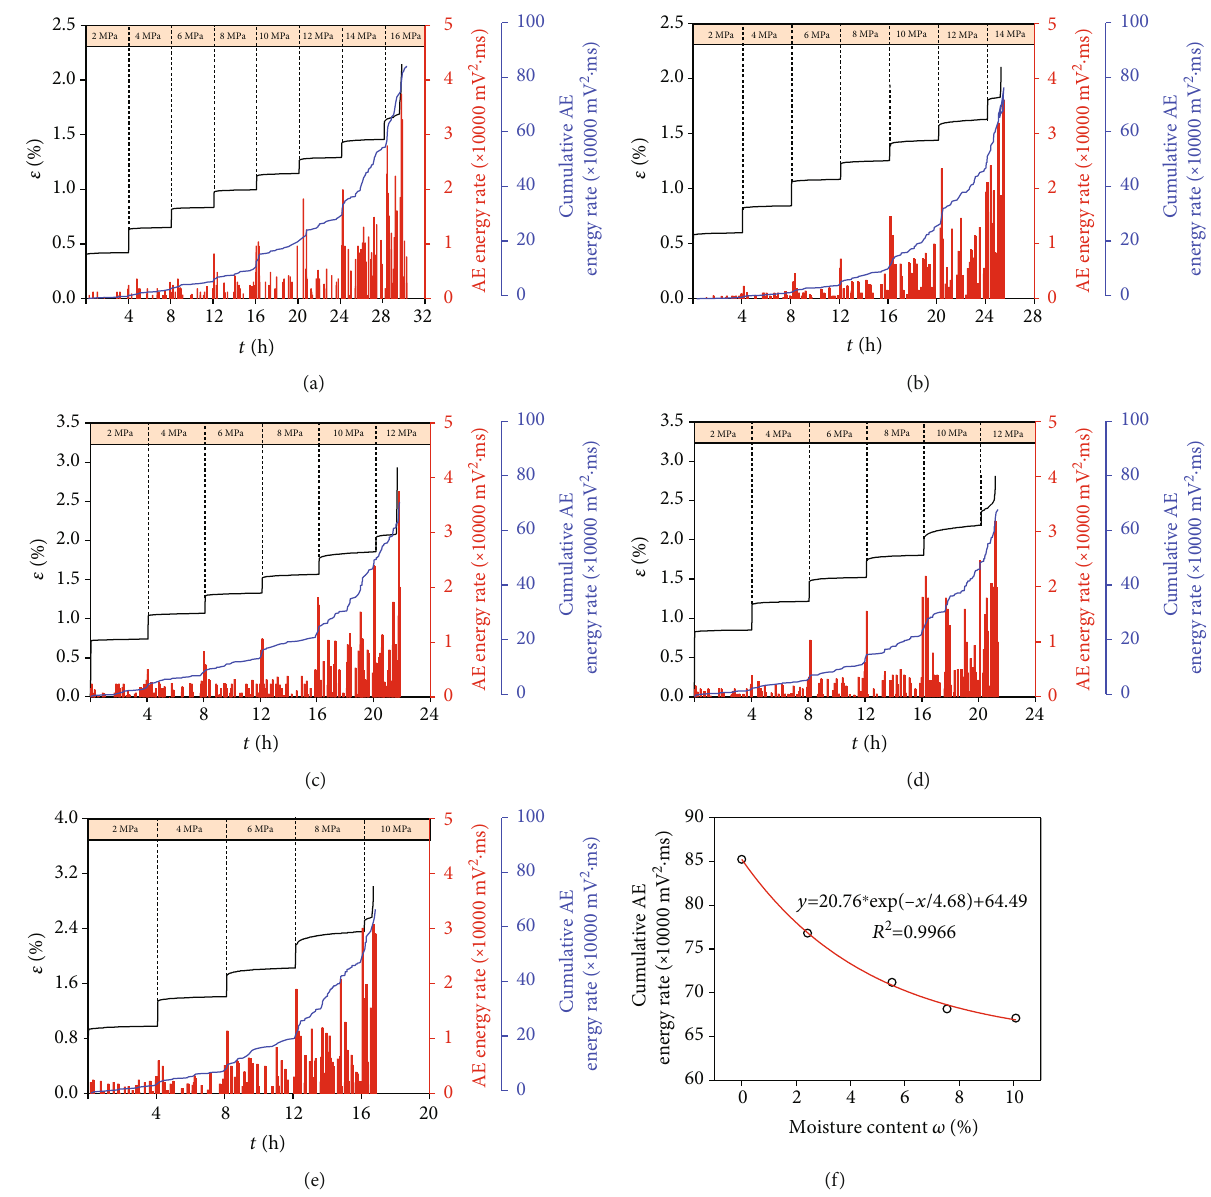
Figure 14: Variation rule of AE energy and accumulated AE energy under di ff erent water contents: (a) ω = 0 % , (b) ω = 2 : 42 % , (c) ω = 5 : 53 % , (d) ω = 7 : 55 % , and (e) ω = 10 : 08 % . (f) Cumulative acoustic emission curve with water